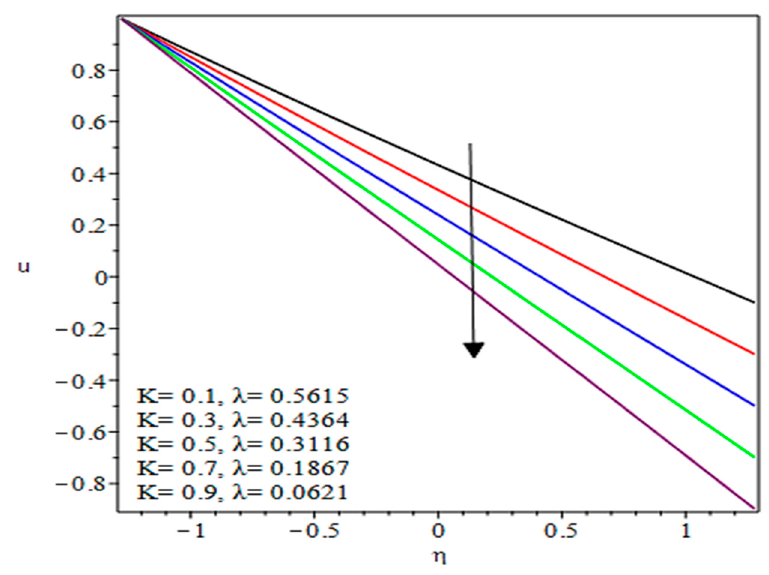
Figure 4. Influence of K on the velocity profile at ξ = 0.75 by fixing M = 0.2 and ζ = 1.